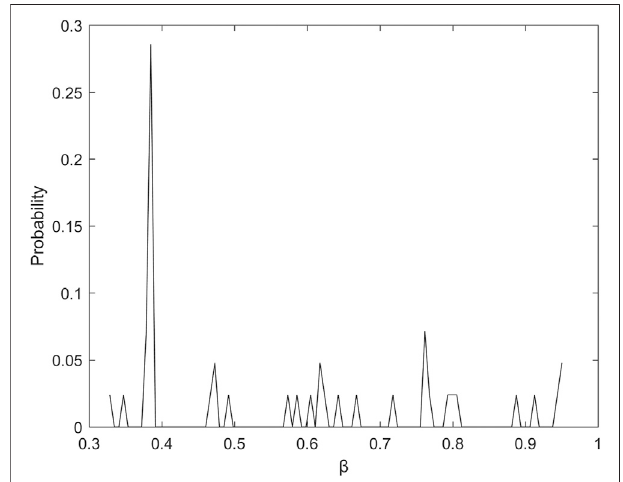
FIGURE 8 | The average delay of multicast trees on different algorithms.